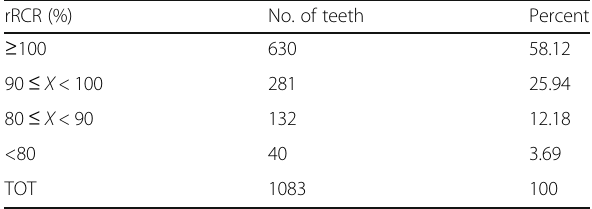
Table 2 Number and percentage of teeth presenting rRCR ≥ 100% (no RR), rRCR between 90 and 100 (slight RR), rRCR between 80 and 90 (moderate RR), rRCR ≤ 80 (severe